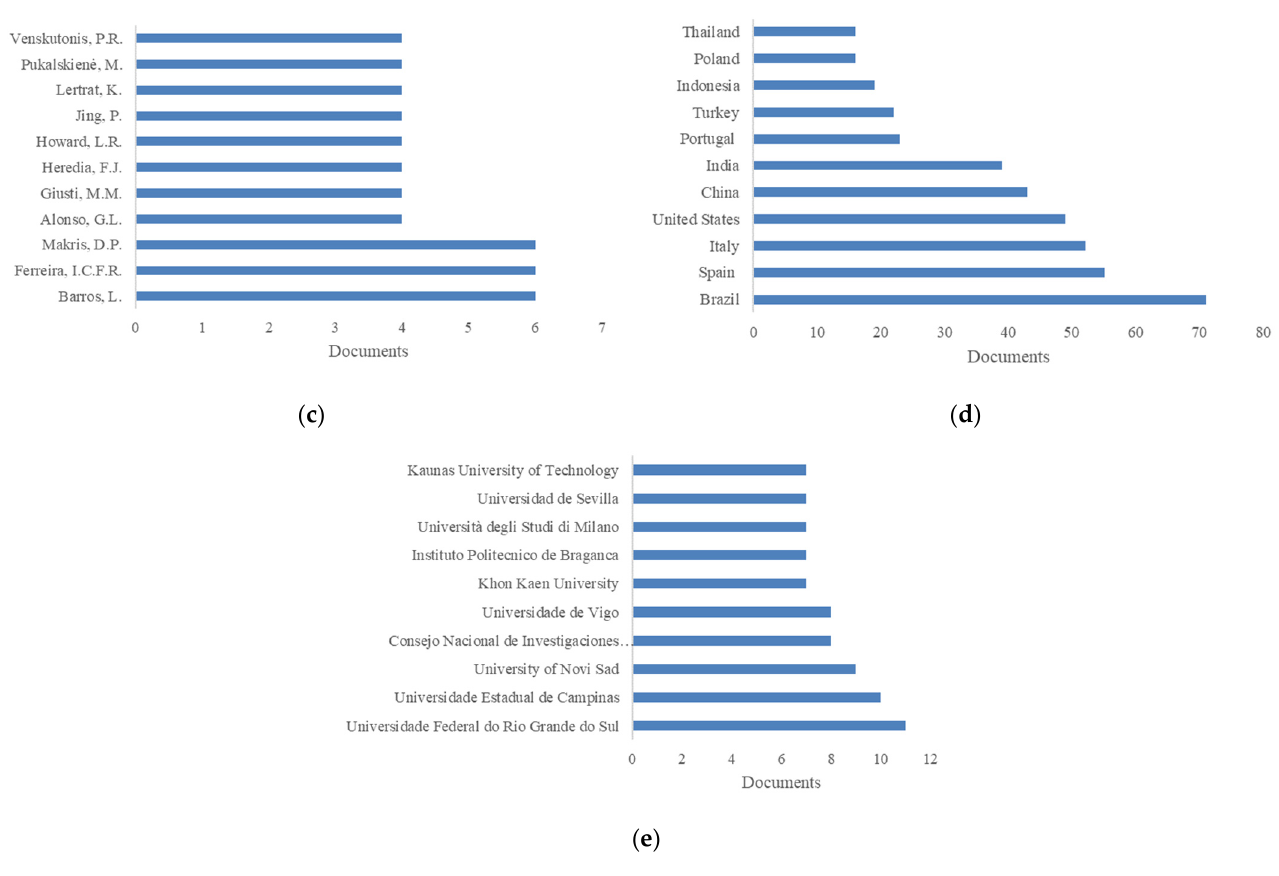
Figure 2. ( a ) Publication trends of anthocyanins, sustainable sources, and wastes relationship search. ( b ) Distribution of documents by type. ( c ) The most productive authors (based on data from Scopus). ( d ) Most productive countries/territories. ( e ) Most productive institutions (based on data from Scopus).